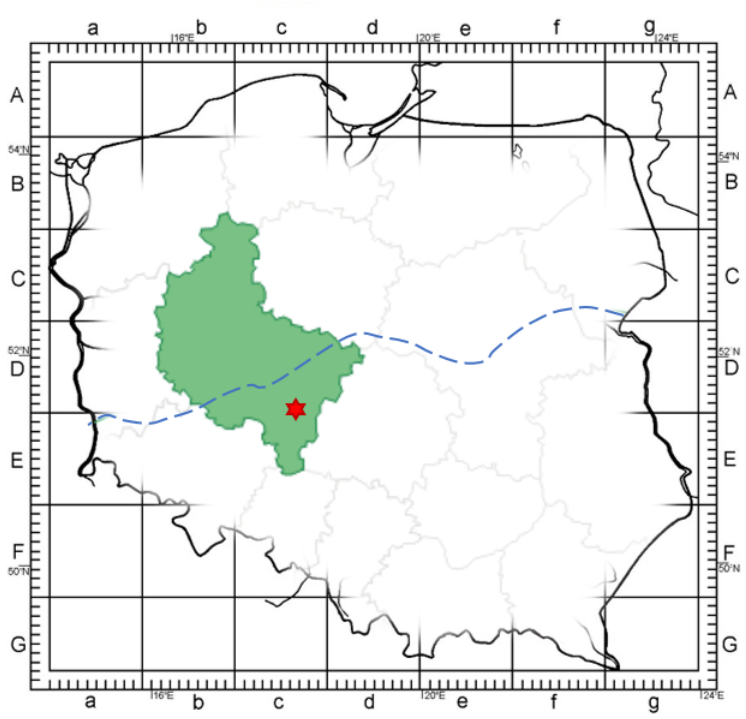
Fig. 1 Distribution of Hericium flagellum in Wielkopolska Voivodship (blue line – northern limit of the natural range of Abies alba in Poland [61]; green area – Wielkopolska Voivodship; red star – the “Olbina” nature